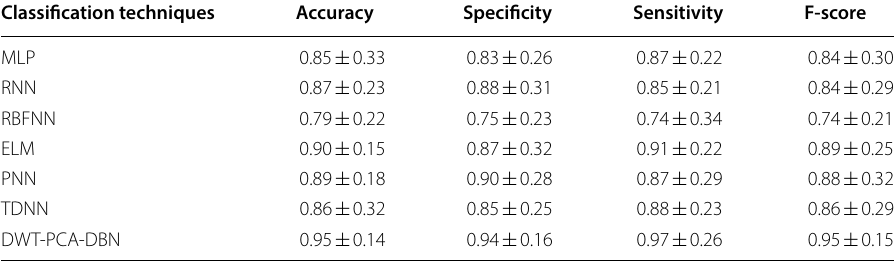
Table 2 Performance comparison between deep learning vs. non-deep learning based approaches Classification